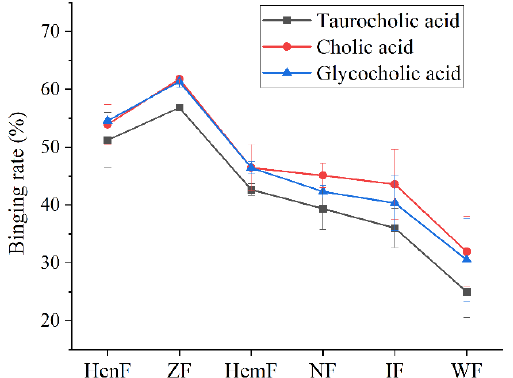
Figure 1. Bile acid binding rate of six Sargassum crude fucoidans. Sargassum crude fucoidans includes HenF, ZF, HemF, NF, IF, and WF, respectively, from Sargassum henslowianum , Sargassum zhangii , Sargassum hemiphyllum , Sargassum naozhouense , Sargassum integerrimum , and Sargassum wightii . Bile acid includes taurocholic acid and cholic acid and glycocholic acid.